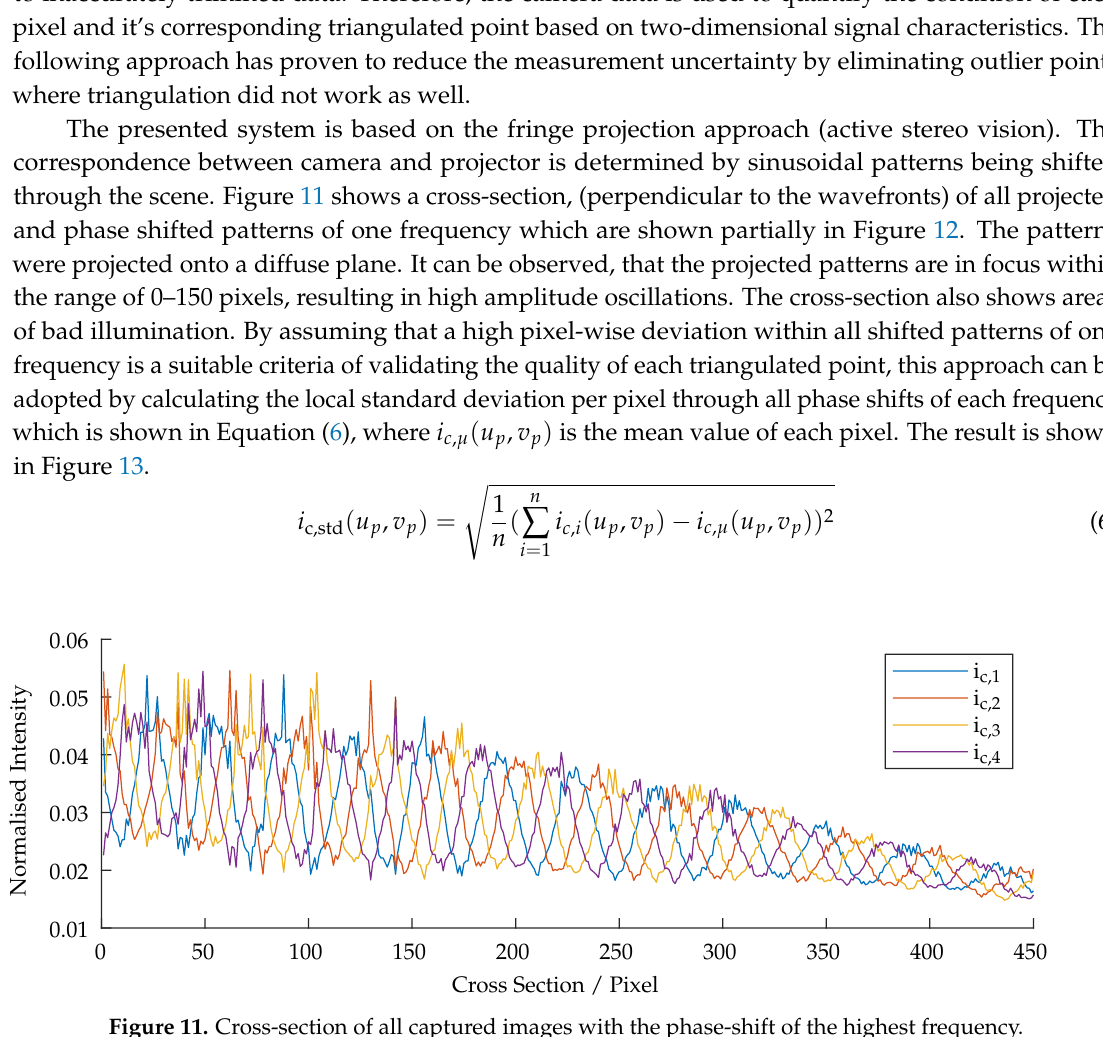
Figure 11. Cross-section of all captured images with the phase-shift of the highest frequency.